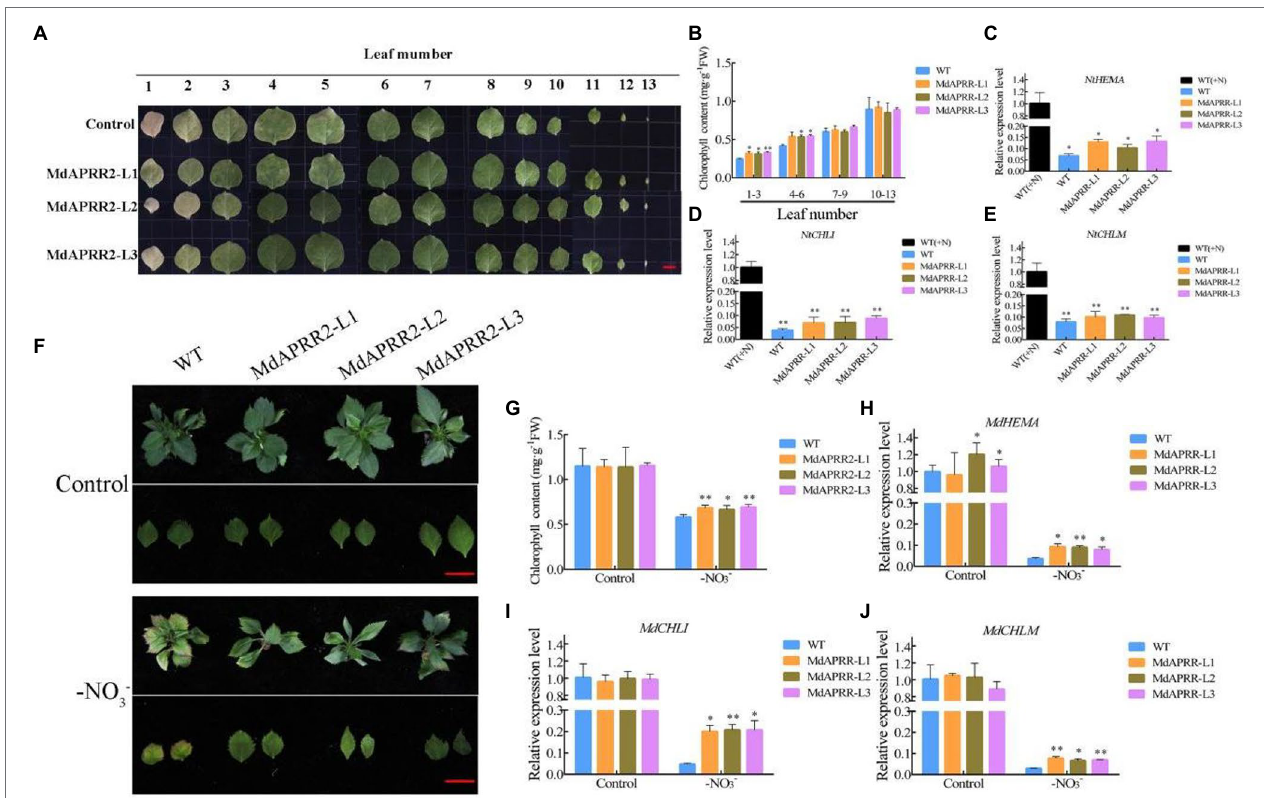
FIGURE 6 | Overexpression of MdAPRR2 delayed chlorophyll degradation induced by N deficiency. (A) Phenotypes of WT (Control) and transgenic tobacco ( MdAPRR2 ) leaves after 3 weeks of N-deficiency treatment; (B) Total chlorophyll content in tobacco leaves indicated in (A) ; (C–E) Expression levels of the chlorophyll synthesis-related genes MdHEMA , MdCHLI , and MdCHLM in tobacco; (F) Phenotypes of WT and transgenic apple ( MdAPRR2 ) leaves after 4 weeks of N-deficiency treatment; (G) Total chlorophyll content in tobacco leaves indicated in (F) ; (H–J) Expression levels of the chlorophyll synthesis-related genes MdHEMA , MdCHLI , and MdCHLM in apple seedlings. The data are expressed as the means ± SDs ( n = 3). Significant differences were detected by a t -test: * p < 0.05 and ** p <